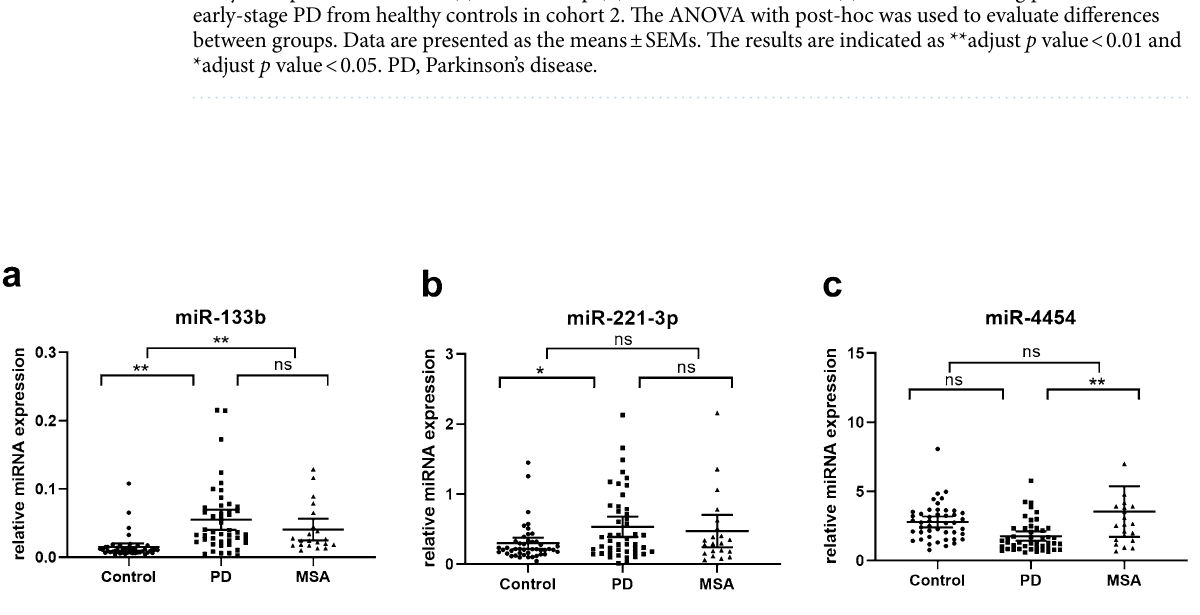
Figure 5. Plasma miR-133b ( a ), miR-221-3p ( b ), and miR-4454 ( c ) expression among patients with PD (n = 46), patients with MSA (n = 21) and healthy controls (n = 45) in cohort 3. The Kruskal–Wallis analysis with post hoc was used to evaluate differences between groups. Data are presented as the means ± SEMs. The results are indicated as ** adjust p value < 0.01, *adjust p value < 0.05, and ns: no significance. PD, Parkinson’s disease; MSA, multiple system